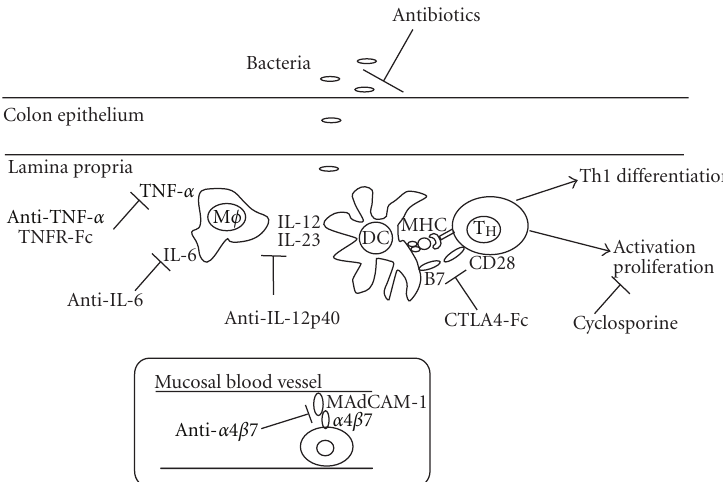
Figure 3: Inhibition of disease pathways in the adoptive transfer model. Schematic representation of drug targets. Table 2: Statistics for all compounds. Clear lines represent prevention studies and bold represent intervention studies. Compound